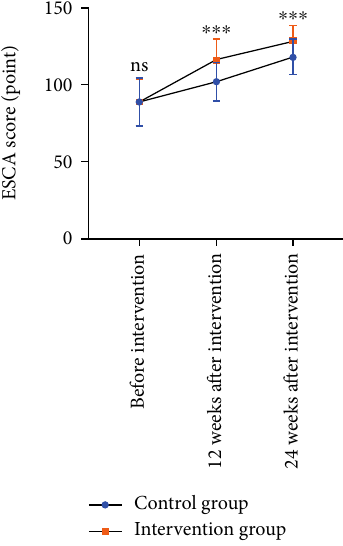
Figure 2: Comparison of ESCA score between the control and intervention groups. n = 74 ; ∗∗∗ p < 0 : 001 . ns: not signi fi cant.